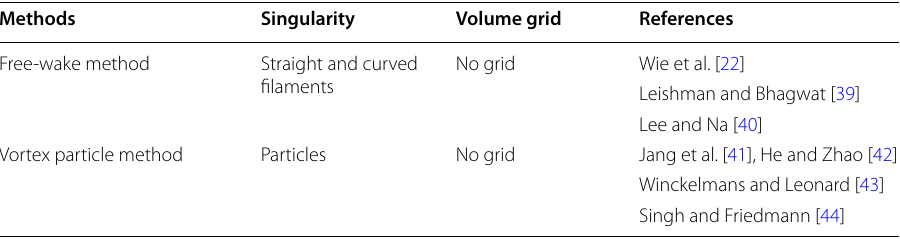
Table 2 Overview of wake models for rotor simulation